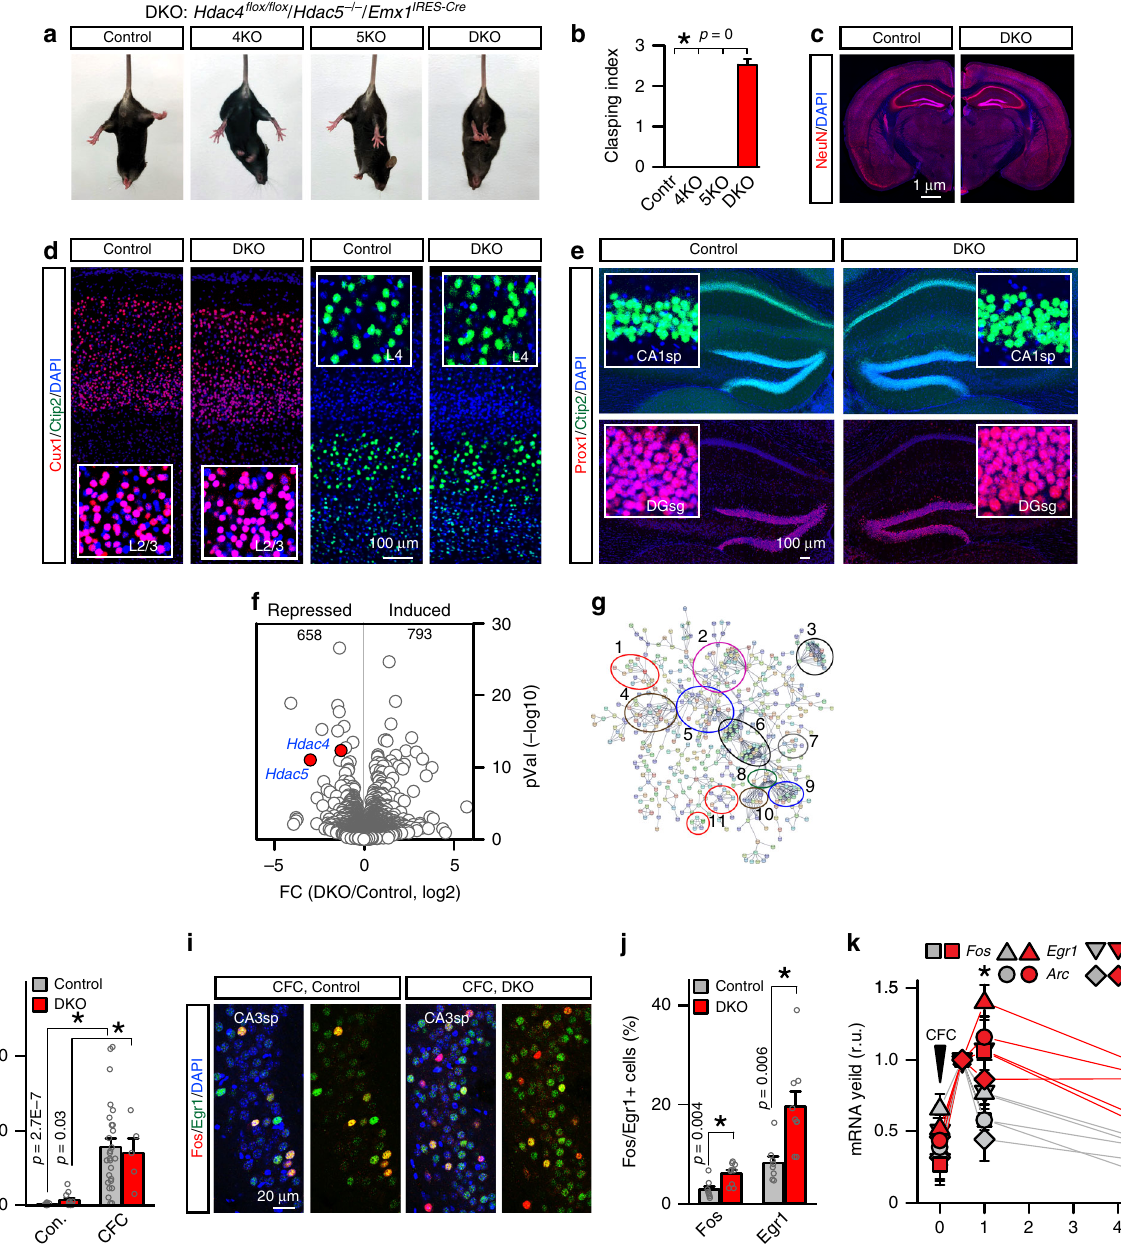
Fig. 2 Characterization of HDAC4/5-de fi cient mice. a Photographs of p60 control, conditional Hdac4 knockout (KO, Hdac4 fl ox/ fl ox /Emx1 IRES-Cre ), constitutive Hdac5 KO ( Hdac5 − / − ), and Hdac4/5 double knockout (DKO, Hdac4 fl ox/ fl ox / Hdac5 − / − /Emx1 IRES-Cre ) mice subjected to tail suspension test. b Averaged leg clasping indexes. n = 20 mice/genotype. c Gross brain anatomies of p60 control and DKO mice. Coronal brain sections were stained with DAPI and the antibody to a pan-neuronal marker, NeuN. See also Supplementary Fig. 5. d , e , Sections were labeled with antibodies against layer/subtype- speci fi c markers of excitatory neurons, Cux1, Ctip2, and Prox1. Images of the primary somatosensory cortex ( d ) and the hippocampus ( e ) are shown. Higher-magni fi cation frames are displayed in inserts. f , g RNA-seq analysis of gene expression in the hippocampus at p60. Volcano plot ( f ) and the STRING network of differentially expressed transcripts ( g ) are shown ( n = 3 mice/genotype). The following clusters are marked: (1) neurotransmitter receptors and calcium channels; (2) cytoskeleton and scaffolds; (3) protein turnover; (4) membrane traf fi cking; (5) calcium signaling; (6) G proteins and G protein- coupled receptors; (7) MAP kinases; (8) adenylate cyclases; (9) dopamine and hormone receptors; (10) phosphodiesterases. See also Supplementary Fig. 6 and Data Files 2 and 3. h – k Expression of ERGs in the hippocampus during associative learning. h Analysis of short-term memory performance, assessed by measuring freezing in the same context 1.5 h post CFC. Control/Control, n = 11; Control/CFC, n = 27; DKO/Control, n = 11; DKO/CFC, n = 5. i Images of CA3sp of fear-conditioned control and DKO mice (1.5 h post CFC). Sections were labeled with DAPI and antibodies against Fos and Egr1. j Quanti fi cations of Fos/Egr1-positive cells in CA3sp. n = 3 mice/genotype. k Transcripts were isolated from hippocampi at indicated time points after CFC and expression levels of various ERGs were measured by qPCR. Values from four to fi ve mice per genotype/time point are normalized to 30 min post CFC to highlight the prolonged window of ERG expression in DKOs. * p < 0.05 ( t -test). The color coding is the same as in j . All quanti fi cations are represented as Mean± SEM (error bars). * p < 0.05 (de fi ned by ANOVA and/or t